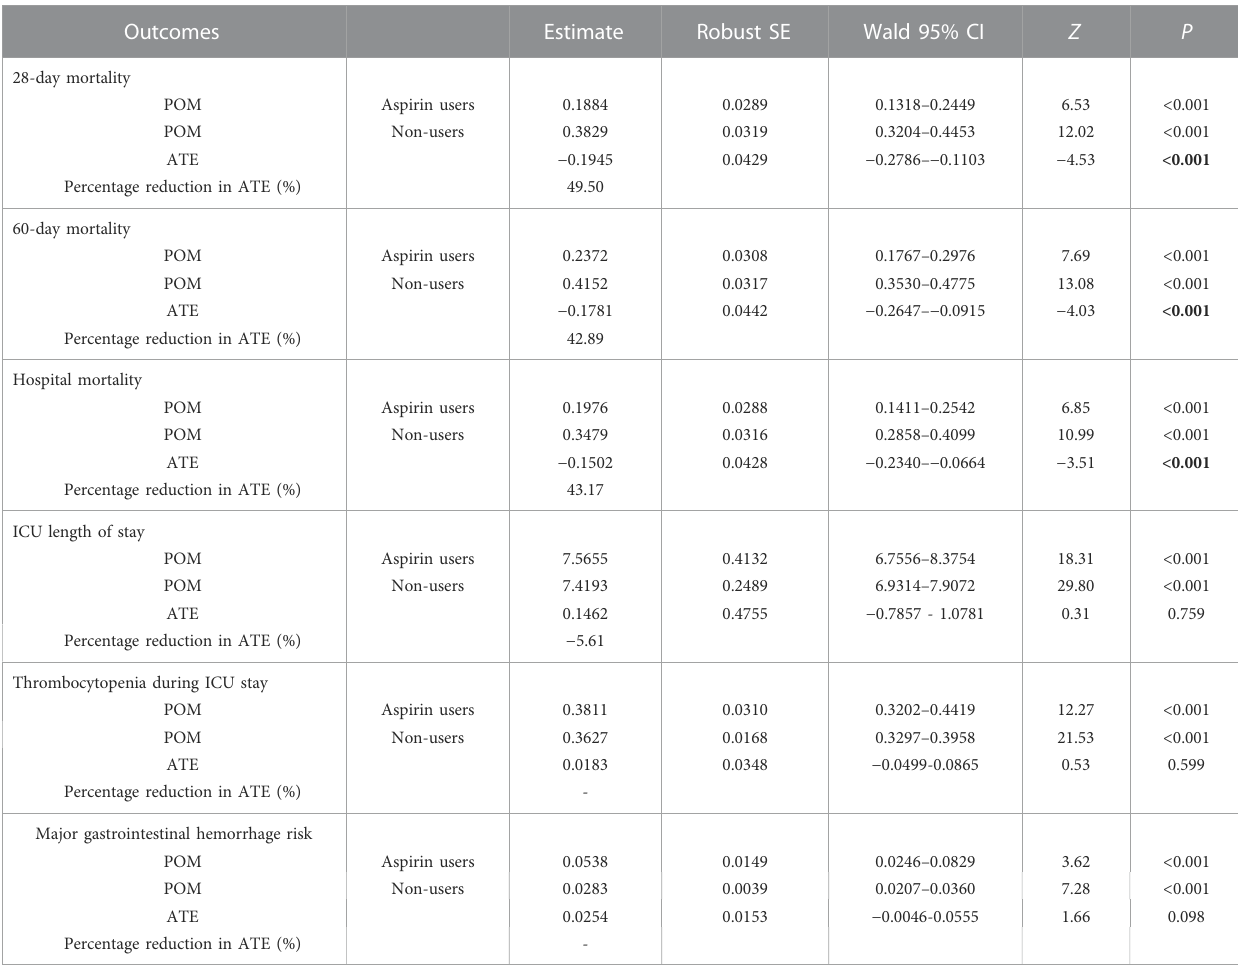
TABLE 1 Augmented inverse propensity weighted analysis of causal effect of pre-ICU aspirin exposure on 28-day mortality, 60-day mortality ICU, hospital mortality, ICU length of stay, thrombocytopenia and major gastrointestinal hemorrhage risk. Outcomes